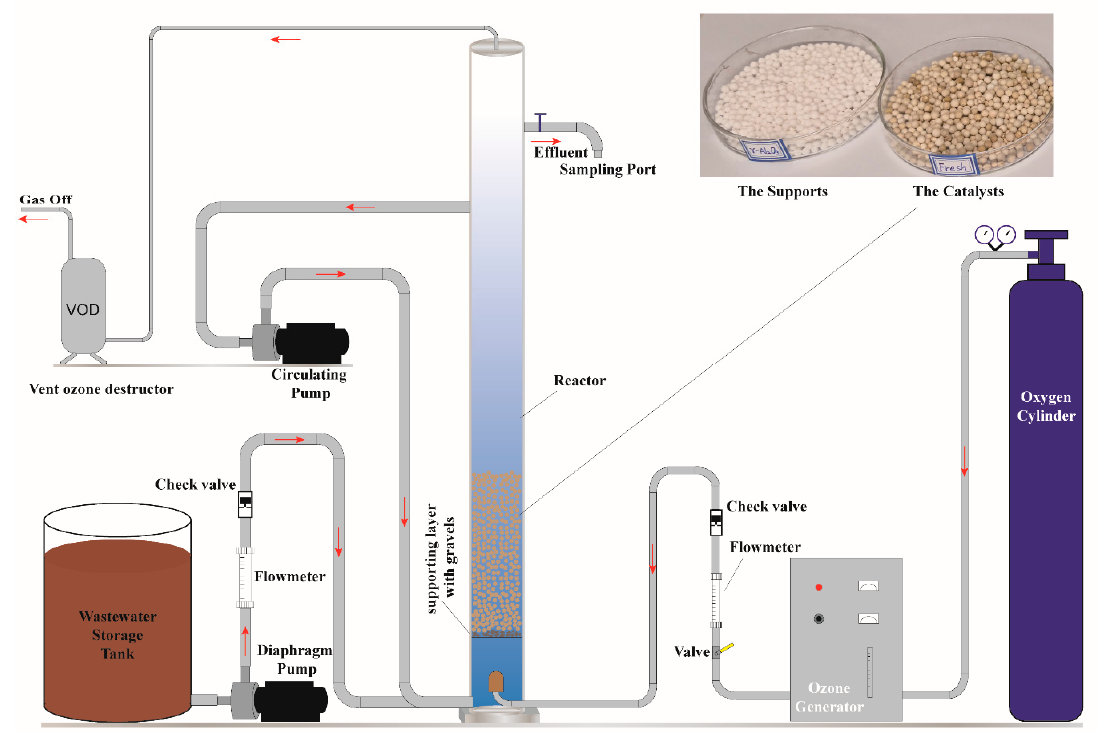
Figure 1. Schematic diagram of catalytic ozonation process for the pilot experiments.